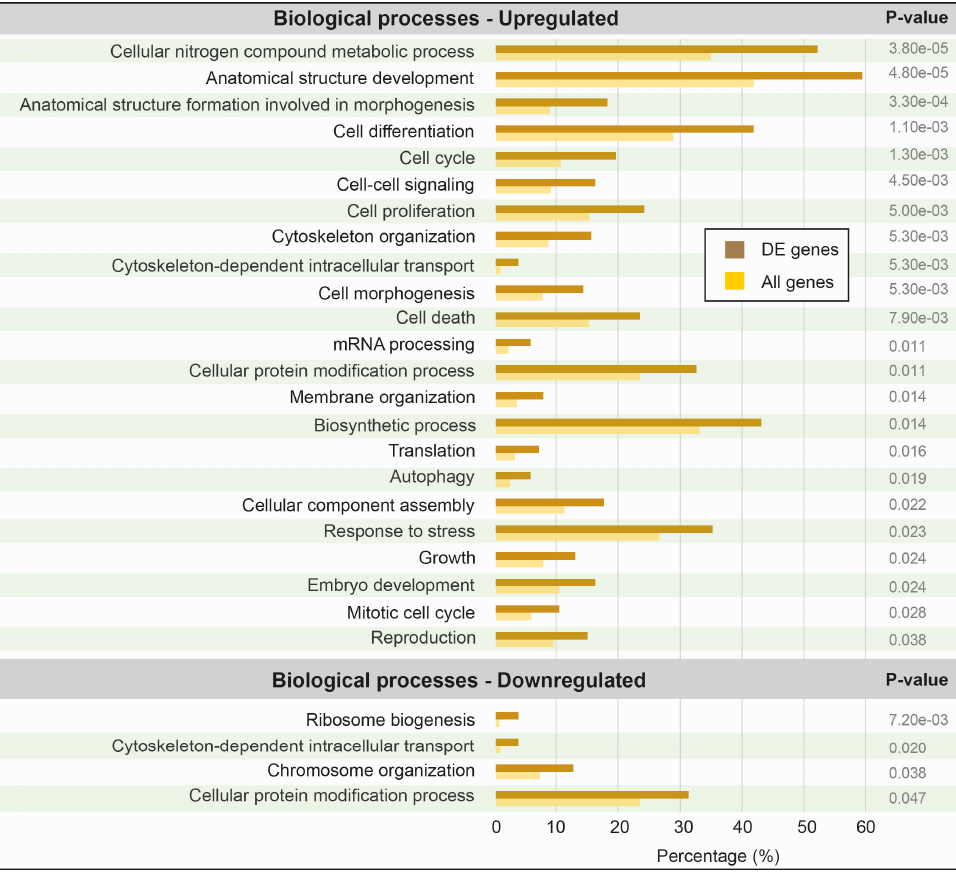
Figure 3. Gene ontology (GO) enrichment of differentially expressed transcripts between KCl-activated and control iPSC-derived neurons. The set of proteins derived from consistent differentially expressed transcripts was submitted to a gene ontology assignment protocol using tools from the AgBase portal (version 2.0) [25]. Results for the biological processes output were compared with the biological processes output for the entire set of annotated human proteins. Each broad class was quantitatively assessed to compare the percentage of entries from differentially expressed transcripts (brown) and the percentage of entries from the entire human proteome (yellow). A p -value was calculated for each class and the significantly overrepresented classes are shown in this figure. The blue color scale on the right represents the relative strength of each p -value, although all are below the significance cutoff of 0.05. DE: differentially expressed.